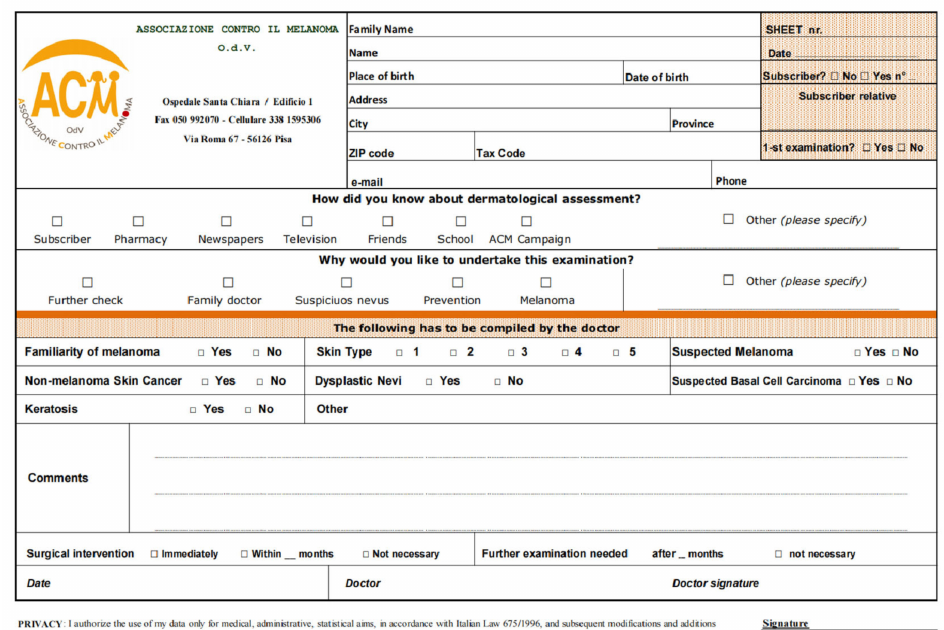
Figure 1. Form filled by subjects and doctors at each visit. O.d.V. (Organizzazione di Volontariato) is a kind of non-profit